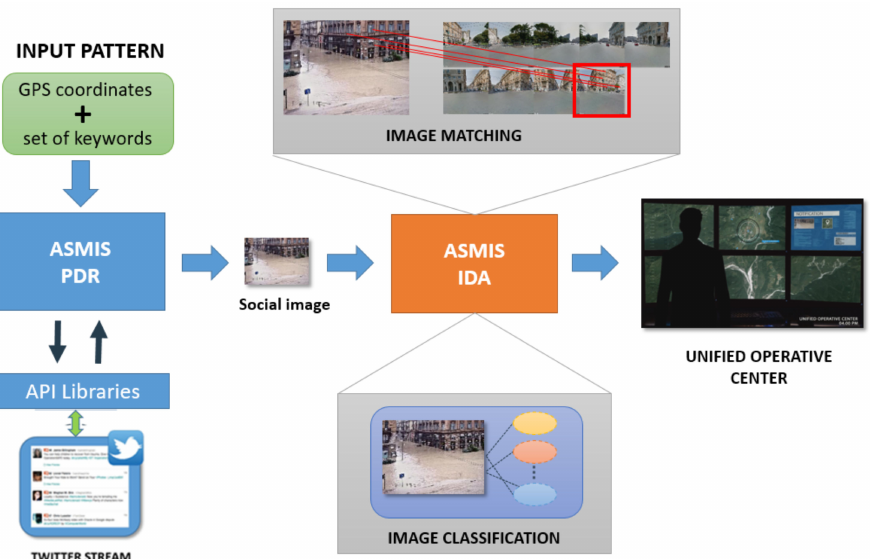
Figure 2. Logical architecture of the ASMIS system for automatic analysis of visual content shared by users on Twitter, including the PDR (Post Data Retriever) module and the IDA (Image Data Analyzer)